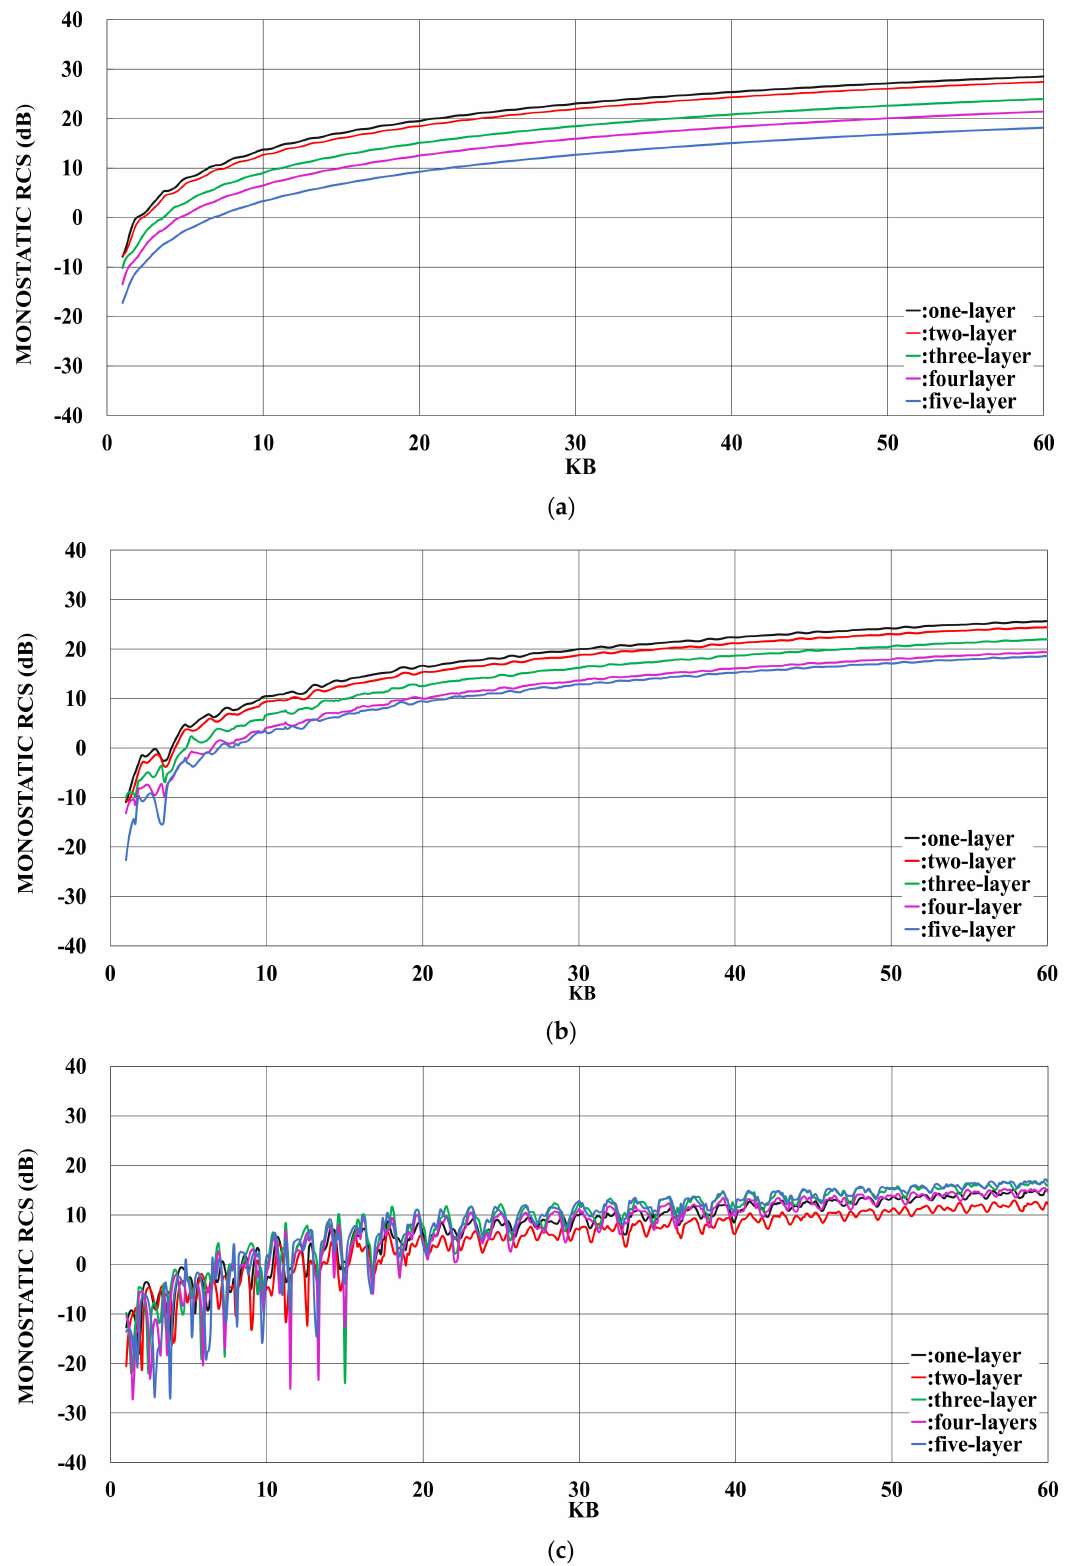
Figure 6. Monostatic RCS [dB] versus normalized frequency kb for θ 0 = 0 ◦ , 30 ◦ , and 60 ◦ , L 1 /2 b = 1.0, kt = 1.57. Other particulars are the same as in Figure 2. ( a ) θ 0 = 0 ◦ . ( b ) θ 0 = 30 ◦ . ( c ) θ 0 = 60 ◦